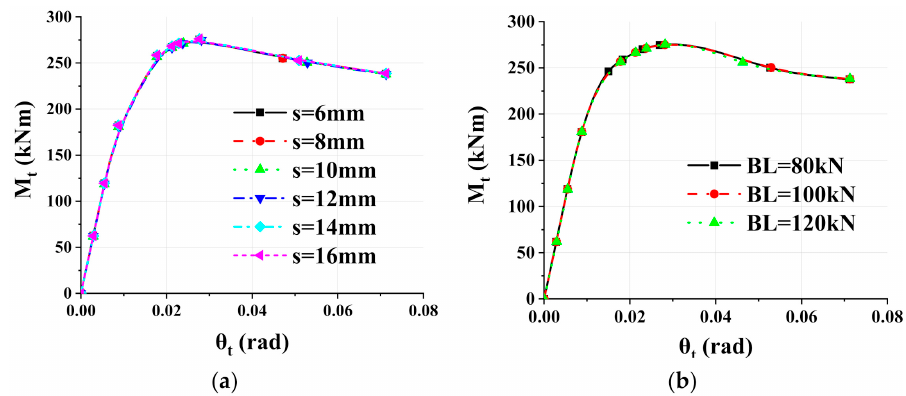
Figure 8. Moment-rotation curves: ( a ) Thickness of side plate; ( b ) Bolts preload. The influence rule of side plate thickness and bolts preload on relative dislocation between upper and lower columns were shown in Figure 9. When the moment is below 200 kNm, the curves almost coincide and increase linearly, indicating that the thickness of the side plate has little influence on the relative dislocation of the upper and lower columns in the elastic stage. When the bending moment reaches 200 kNm, curves entered into the elastic–plastic stage and began to separate. The higher the thickness of the side plate, the smaller the relative dislocation of the side columns. There is no significant difference between the curves with different bolt preload.